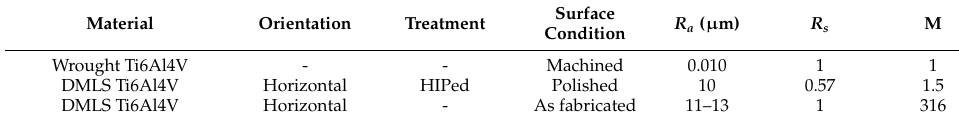
Table 8. Surface finish and microstructural factors for Ti6Al4V ( σ 0 = 600 MPa).